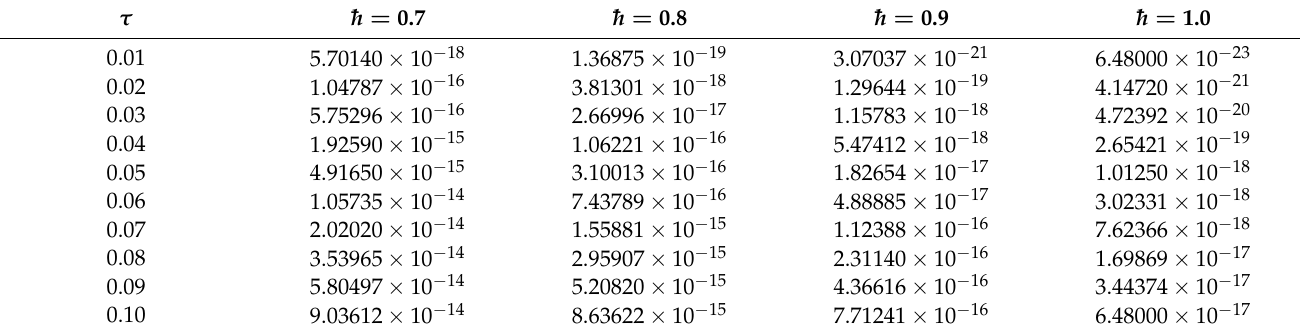
Table 6. The | Ω 6 ( α , τ ) − Ω 5 ( α , τ ) | of Problem 4.2 at varying values of ¯ h at α = 1.0 determined by the ARPSM at plausible locations in the range τ ∈ [ 0, 0.10 ] .